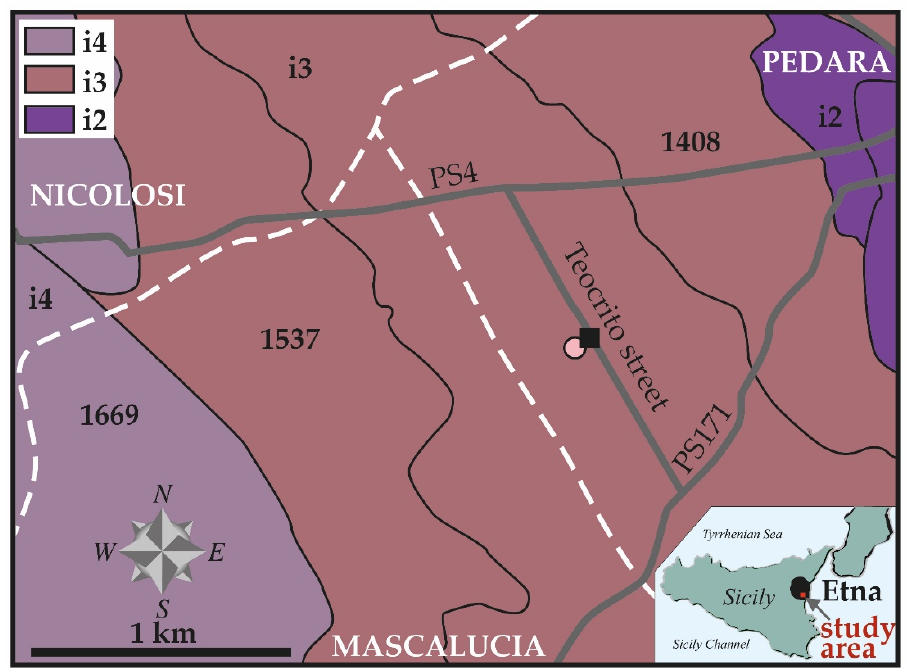
Figure 6. Geological map with the localization of the burial site (pink circle) [95,96,99,109,110] and sample 1 (black square). Legend—Formation Torre del Filosofo of the Mongibello Unit: (i4) historical lava flows of the 1669–1971 time interval; (i3) historical lava flows of the 122 B.C. and 1669 time interval, (i2) lava flows of the 3900–122 B.C. time interval. The grey and white lines represent the main streets and the municipality limits, respectively.